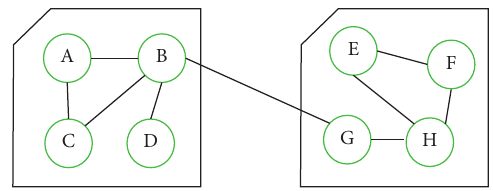
Figure 1: An example modularization for a small software system.